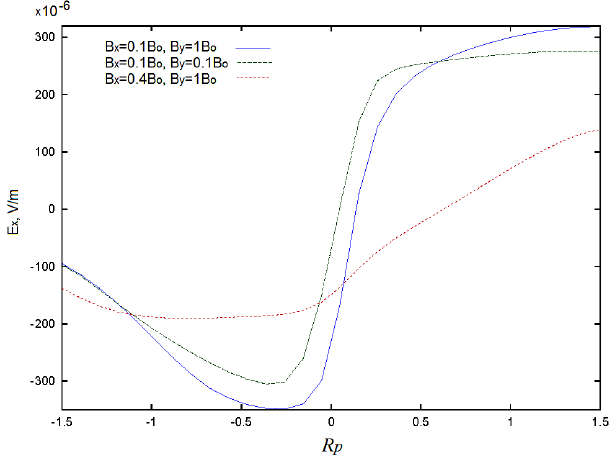
Figure 9. The polarisation (Hall) electric field e E x versus the dis- tance X from the midplane (measured in the units of R p ) induced by accelerated particles at their separation in the midplane ac- cording to different values of B x 0 and B y 0 for the magnitude of B z 0 = 10 − 9